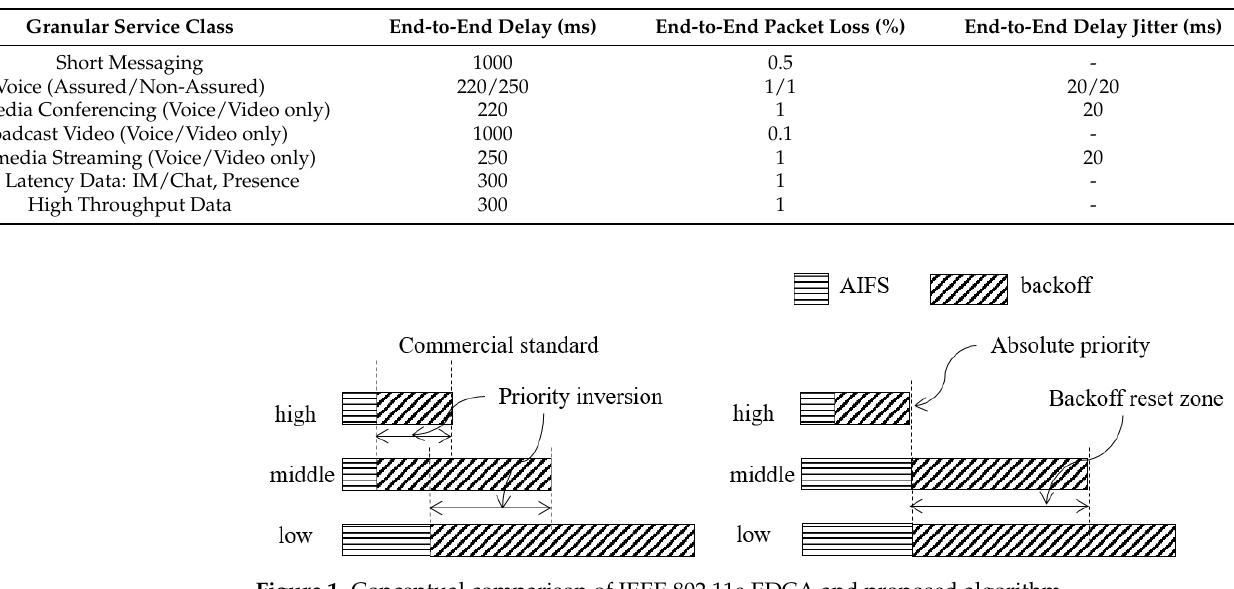
Figure 1. Conceptual comparison of IEEE 802.11e EDCA and proposed